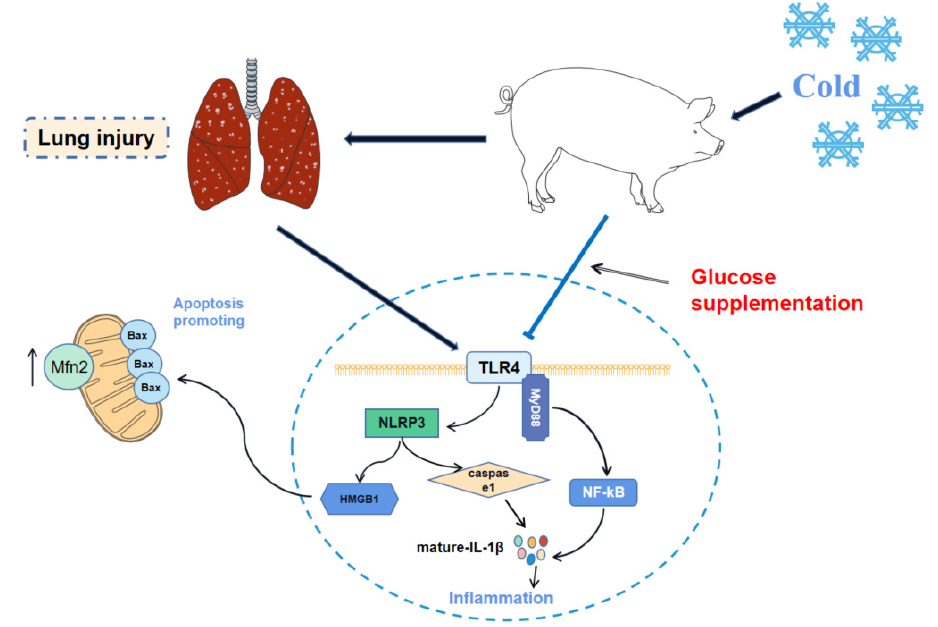
Figure 8. Glucose supplementation alleviates the lung injury induced by chronic cold exposure to some extent. Black arrows indicate up-regulation.